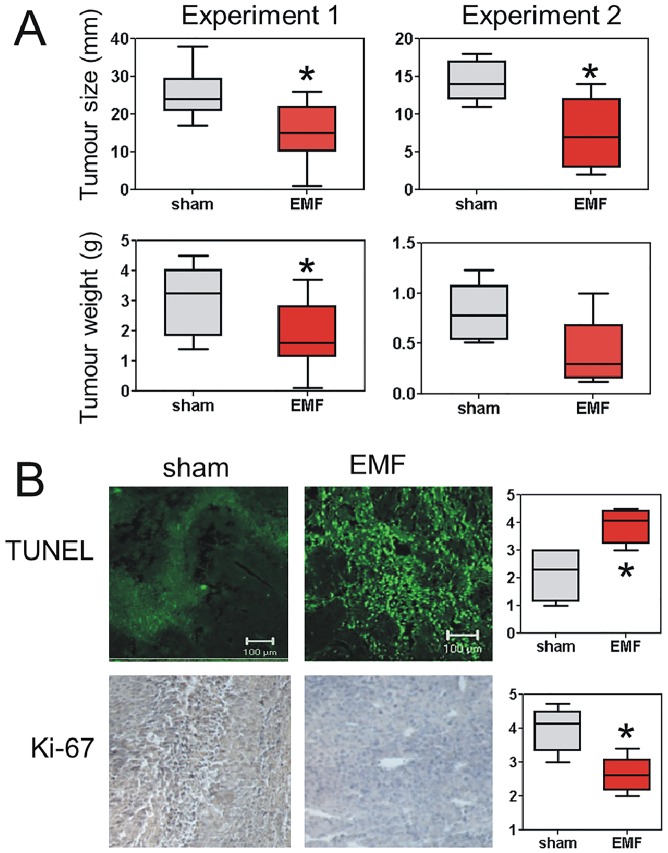
Exposure to Thomas-EMF inhibits B16-BL6 tumour growth in C57b mice.A. A total of 35 male C57b mice (experiment 1 = 25 and experiment 2 = 10 animals) were injected subcutaneously with 106 B16-BL6 cells. The mice were randomly assigned to Thomas-EMF (red) or sham (grey) conditions and exposed for 3 h/day until the animals were sacrificed and tumours dissected. The average size and weight (and 95% CI and range) of the tumours are shown (* indicates p<0.05, Mann-Whitney U-test). B. The tumours from the mice in experiment 2 were fixed, embedded in paraffin, and sectioned for analysis for TUNEL and Ki-67 staining. Staining intensity for each section was assigned on a scale of 1–5 for each microscopic field. For analysis, 5 fields/tumour were scored for each mouse and the average (and 95% CI and range) of scores for 5 mice/condition were compared (* indicates p<0.05, Mann-Whitney U-test). Sections corresponding to average staining scores for each group are shown.